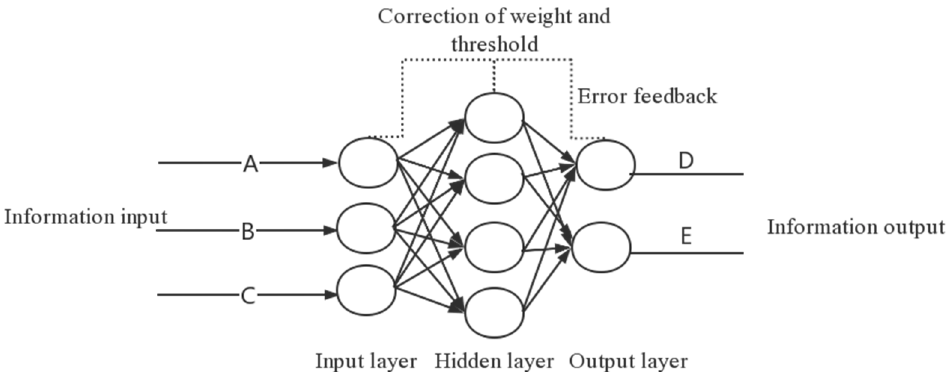
Figure 2. Structure diagram of BP neural network. (A. B, C represents the input value, D, E represents the output value)